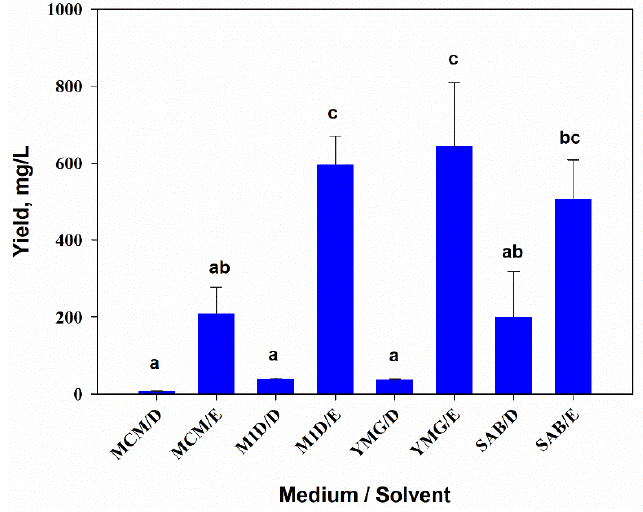
Figure 1. Yield of extractive matter from the filtrate of Alternaria tenuissima MFP253011 cultures on various liquid media obtained by successive extractions with dichloromethane (D) and ethyl acetate (E). Means ± standard deviation ( n = 3) marked with the same letter did not differ significantly at the level of p = 0.05 according to Tukey’s HSD test.